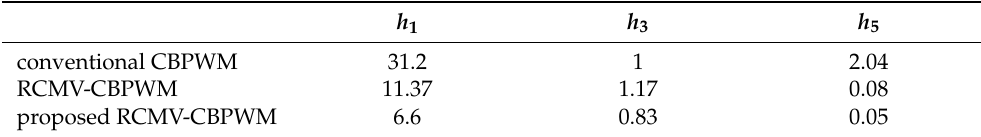
Table 5. Harmonic content of CMV for case